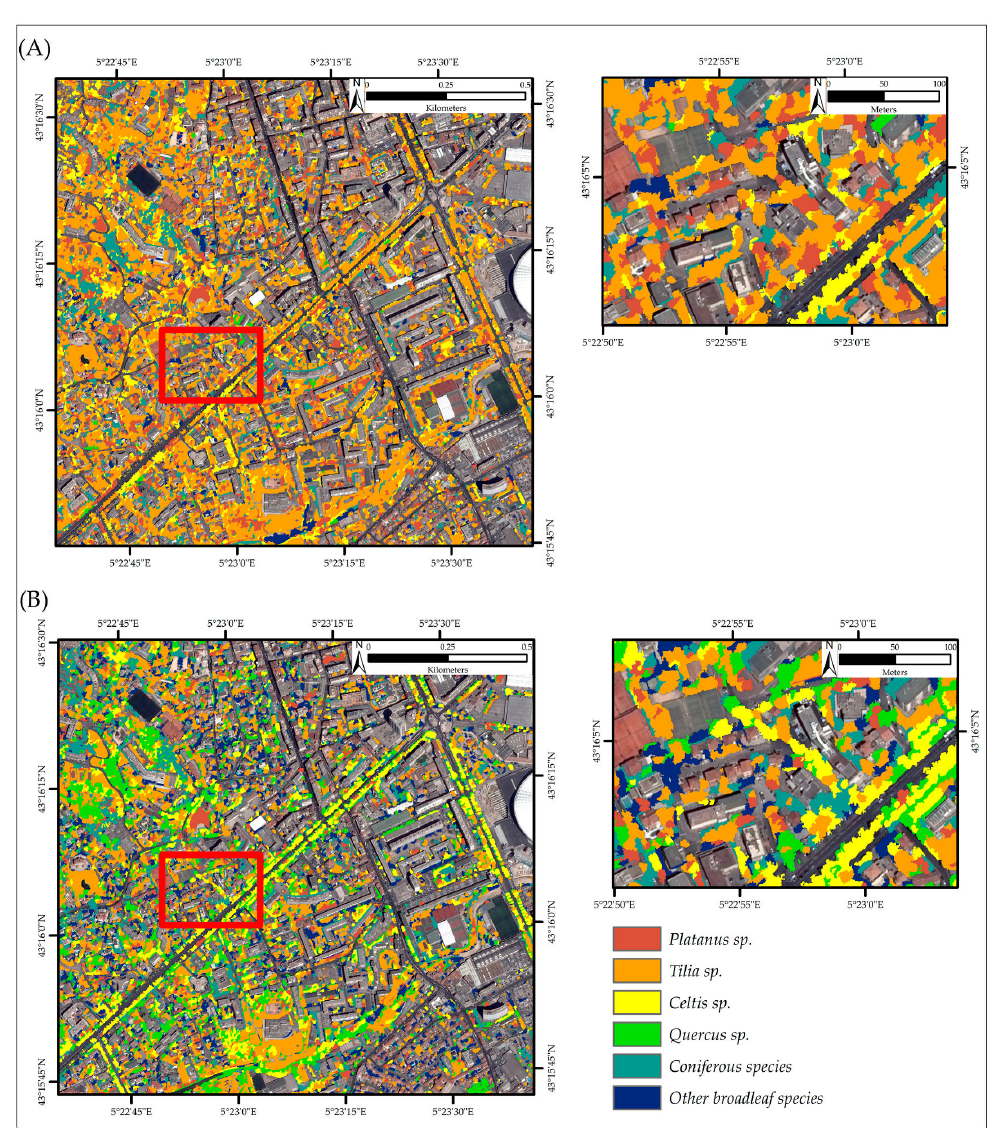
Figure 6. Classification maps based on object-based RF model using ( A ) single-date Pl é iades image and ( B ) bi-temporal Pl é iades